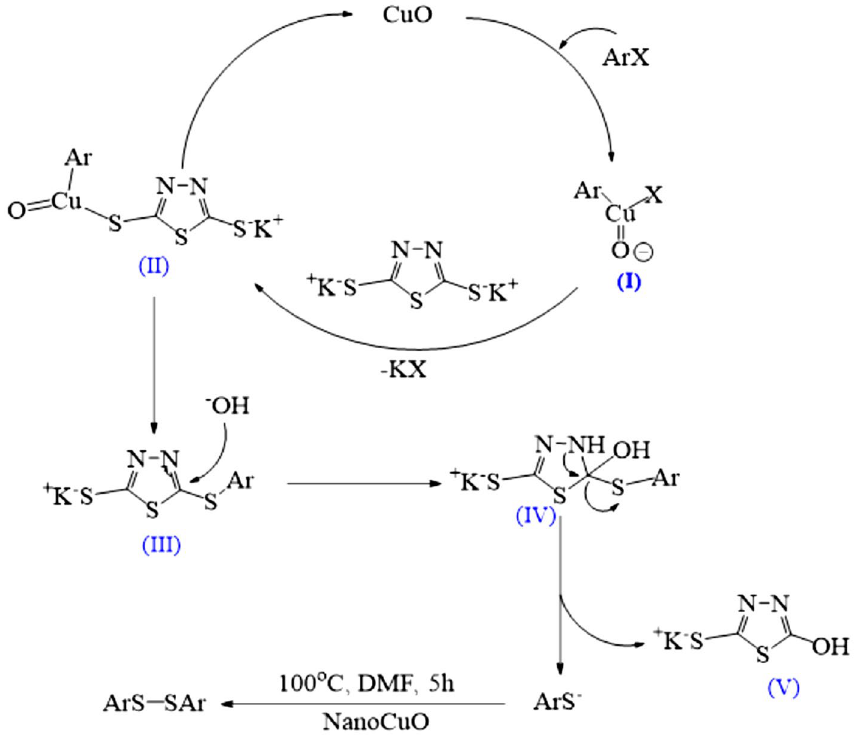
Figure 10. A possible mechanism for the synthesis of